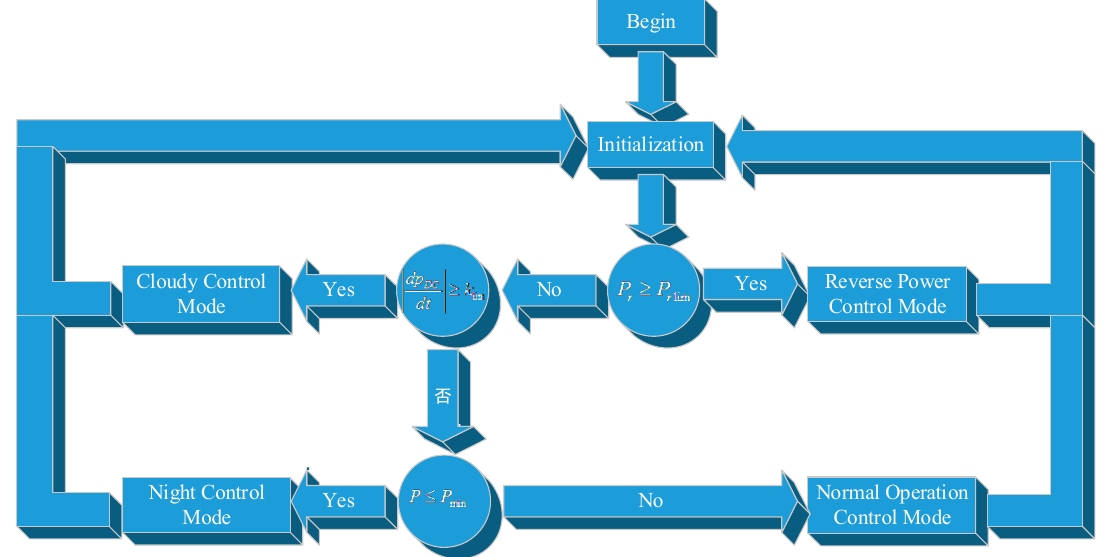
Figure 3. Operation flow of the switching method between different control modes.